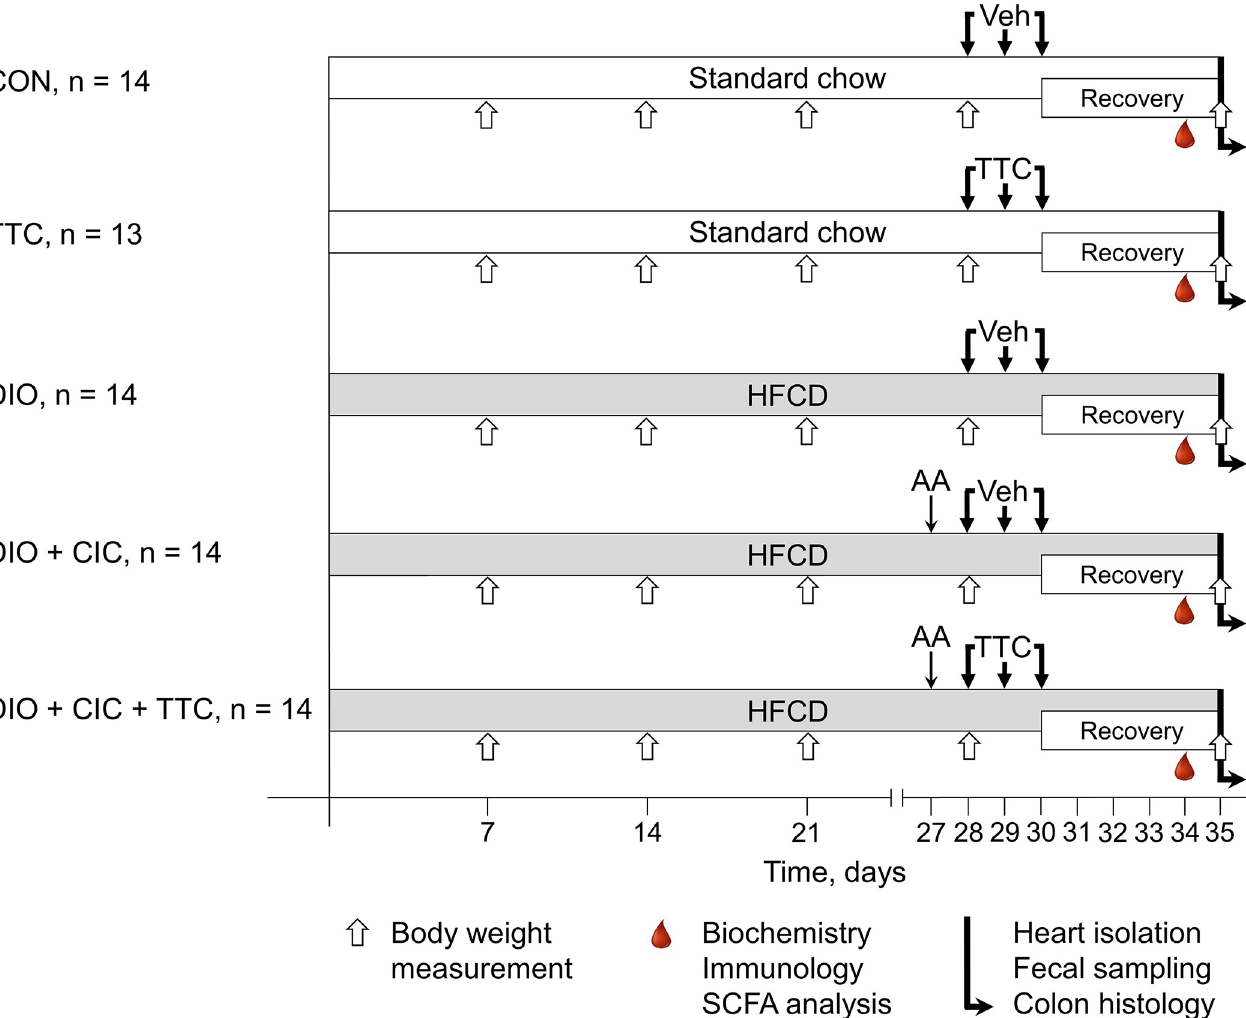
Fig 1. Experimental design. For details, see text. AA–acetic acid, HFCD–high-fat, high-carbohydrate diet, Veh–vehicle, TTC–tetracycline, SCFAs–short chain fatty